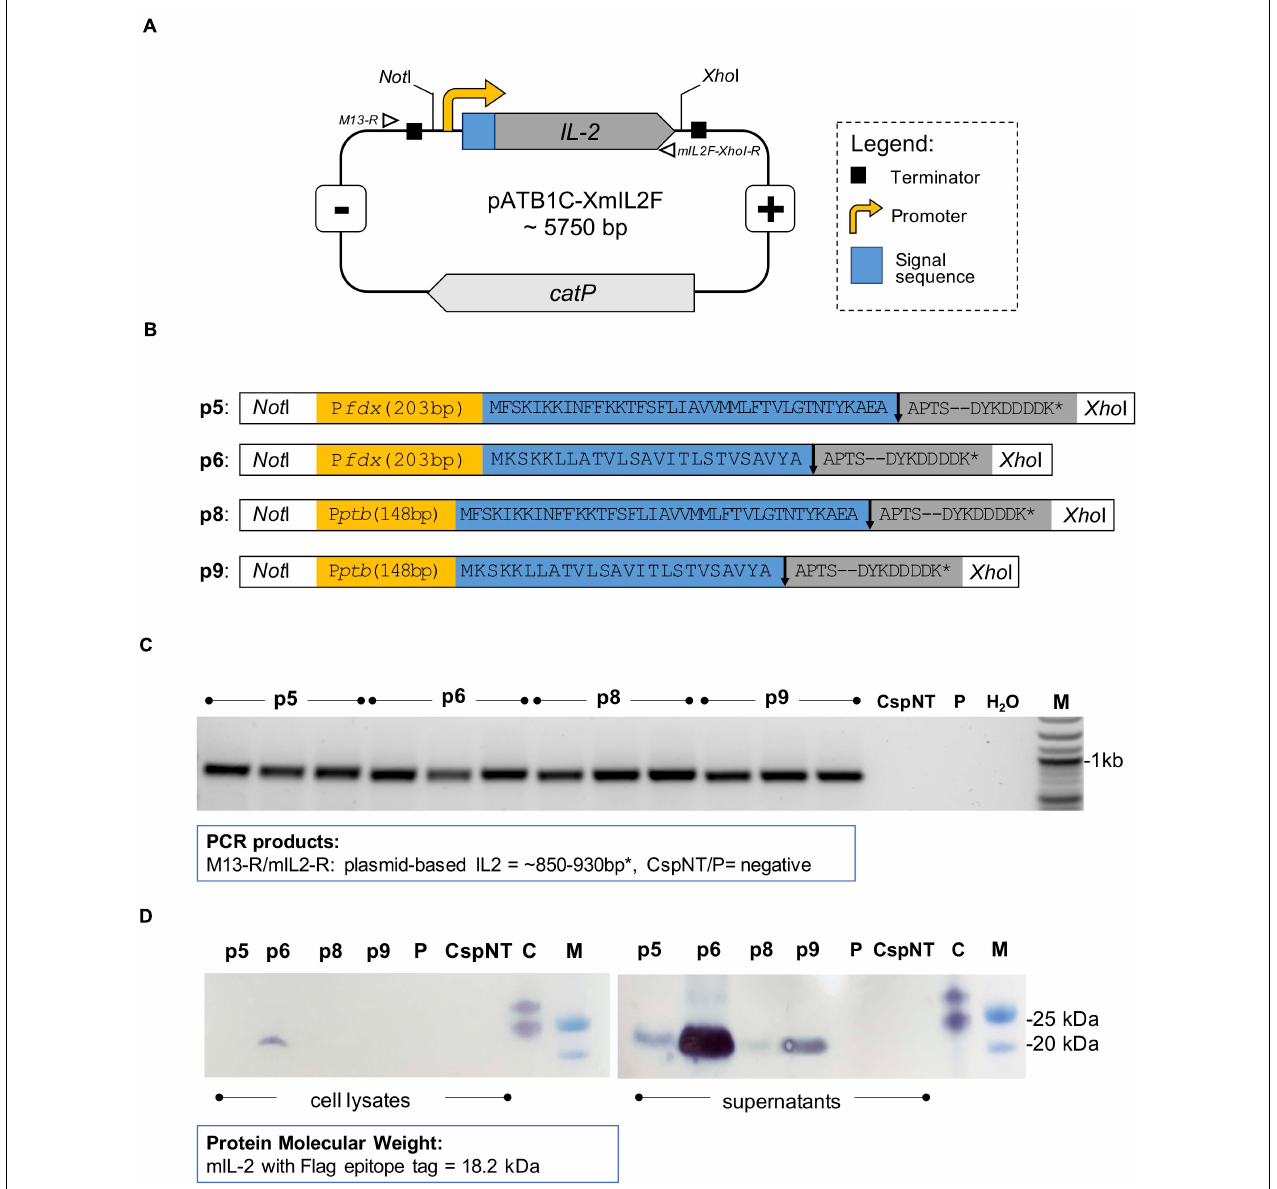
FIGURE 5 | Design and confirmation of C. sporogenes -NT-XmIL2F variants. (A) Schematic illustration of expression vector pATB1C-XmIL2F. The codon optimised and FLAG-tagged murine IL-2 gene was ligated at the Bsa I site with relevant promoter and signal sequence variants ( Supplementary Table 3 ) and inserted into pMTL82121 vector at the Not I/ Xho I sites. Open triangles indicate alignment of screening primers: M13-R and mIL2F- Xho I-R. (B) Four mIL2 expression modules consist of P fdx or P ptb promoter (yellow box) followed by eglA or nprM3 signal sequence (blue box). The FLAG-tagged murine IL-2 gene (grey box) was ligated downstream of a relevant signal sequence. The arrow indicates the signal sequence cleavage site. (C) Colony PCR screening of C. sporogenes -NT transconjugants harbouring four variants of plasmid-based mIL-2 gene. For each variant a total of three independent clones have been obtained. Plasmid-based mIL-2 strains were denoted p5, p6, p8 and p9 ( Supplementary Table 1 ), “CspNT” denotes C. sporogenes -NT control, “P” denotes C. sporogenes -NT-pATB1C (empty vector), water (dH 2 0), M: DNA marker. (D) Visualisation of Western immunoblot analysis performed on C. sporogenes -NT-XmIL2F cell lysates and supernatant fractions following the incubation with FLAG-tag antibody. “C” denotes FLAG-tag positive control, “M” denotes protein marker. FLAG-tagged murine IL-2 protein has been visualised